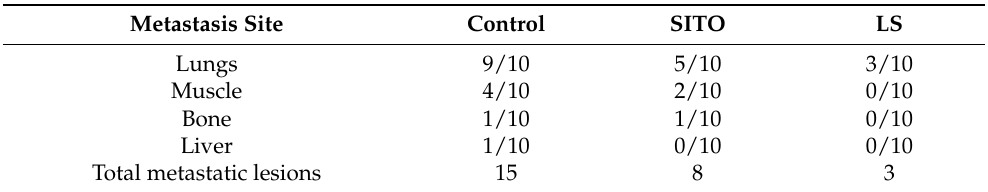
Figure 4. Liposomal β -sitosterol (LS) strongly repressed tumor progression in the lungs. ( A ) Representative images of lungs from the Control, SITO, and LS-treated mice. Lungs were removed after the last BLI, and the number of metastatic lung colonies was counted. Mice treated with LS had the fewest lung colonies compared with the Control and SITO groups. ( B ) Representative images of H&E-stained lung sections from animals (40× magnification). Scale bar = 100 μ m. (**** p < 0.0001 compared with the Control; ## p < 0.01 compared with SITO). Table 1. The number of metastatic lesions was determined using a combination of ex vivo BLI and a histological analysis of all mice upon